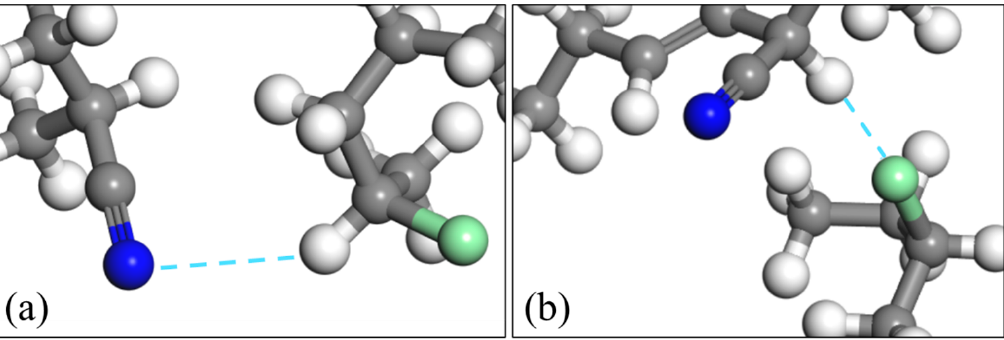
Figure 6. Schematic diagram of analogous hydrogen bonds in the CP52/NBR system. ( a ) Type I. ( b ) Type II.